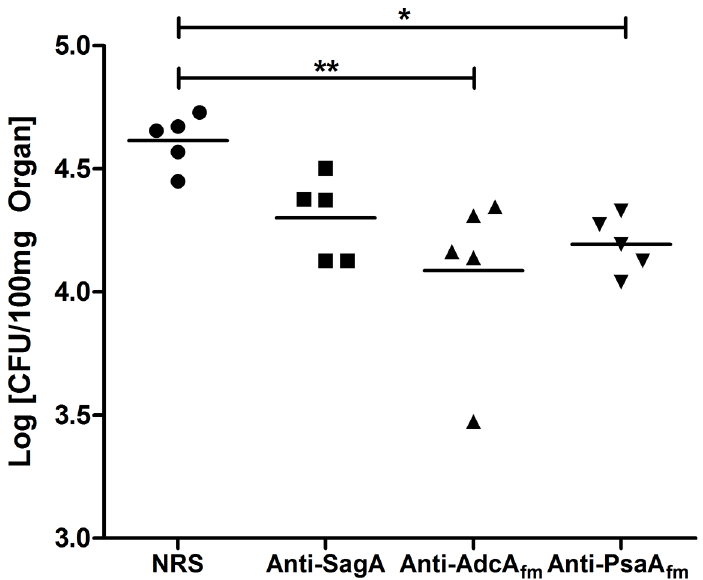
Fig 5. Passive Immunization with the antibodies raised against the recombinant proteins promotes clearance of E . faecium in mouse liver in comparison with normal rabbit serum. 24 hours after the bacterial challenge mice were sacrificed and livers were removed to assess viable counts. Each point represents the bacterial counts from a single mouse. Bars indicate the median CFU/100 mg of kidney for the group. P value was < 0.05 ( * P (cid:5) 0.05, ** P (cid:5) 0.01) for comparison between the animals immunized with the antibodies raised against the recombinant proteins and control animals immunized with NRS determined by analysis of variance for multi-group comparisons using on log-transformed data, and Kruskal-Wallis